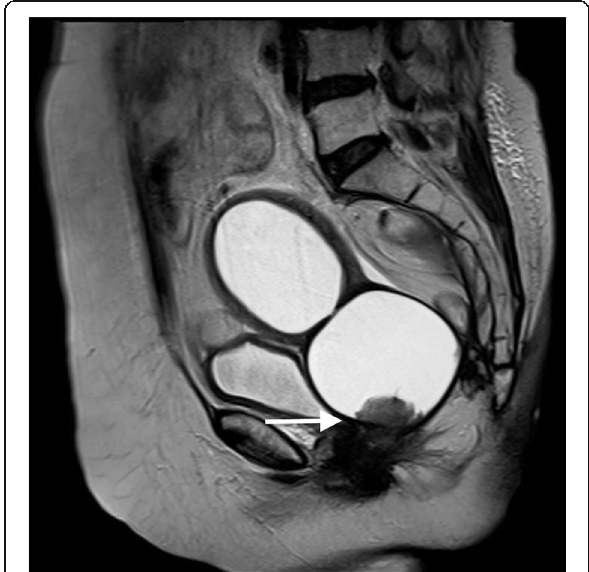
Fig. 4 Sagittal T2-weighted image demonstrates increased T2 signal intensity representing water, filling endometrial and vaginal lumen secondary to obstruction of metastatic lesion (arrow) at the vaginal lumen